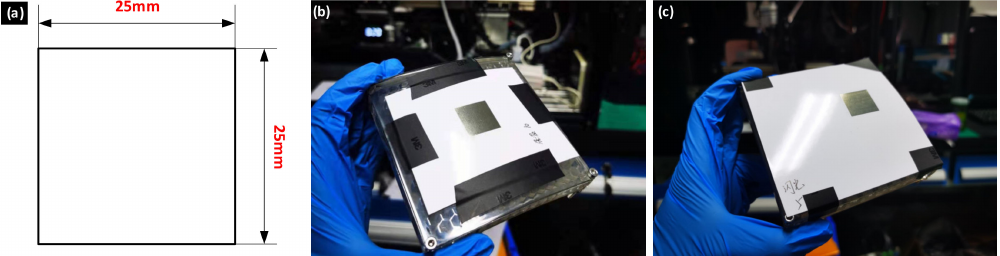
Figure 11. ( a ) Drawings of sheet resistivity sample. ( b ) Sheet resistivity printed directly on conformal surfaces with conventional methodology, and ( c ) with the scheme proposed in this article.